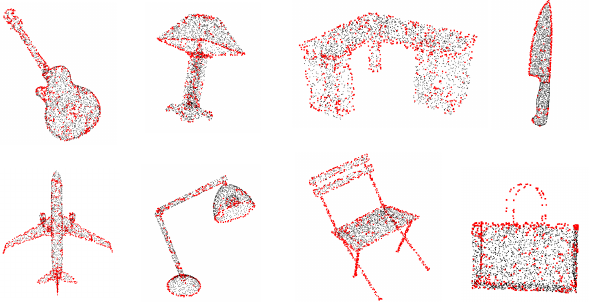
Figure 4. The high-frequency components that reflect sharp features in point clouds are shown in